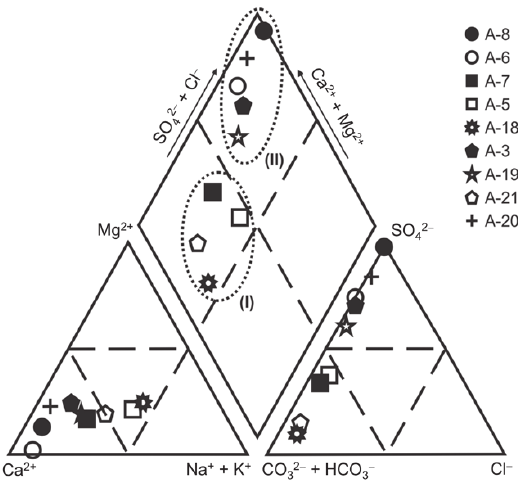
Figure 2 - Classification of stream waters of the study area, according to Piper diagram. Groups I and II refer to waters least and most affected by acid mine drainage,